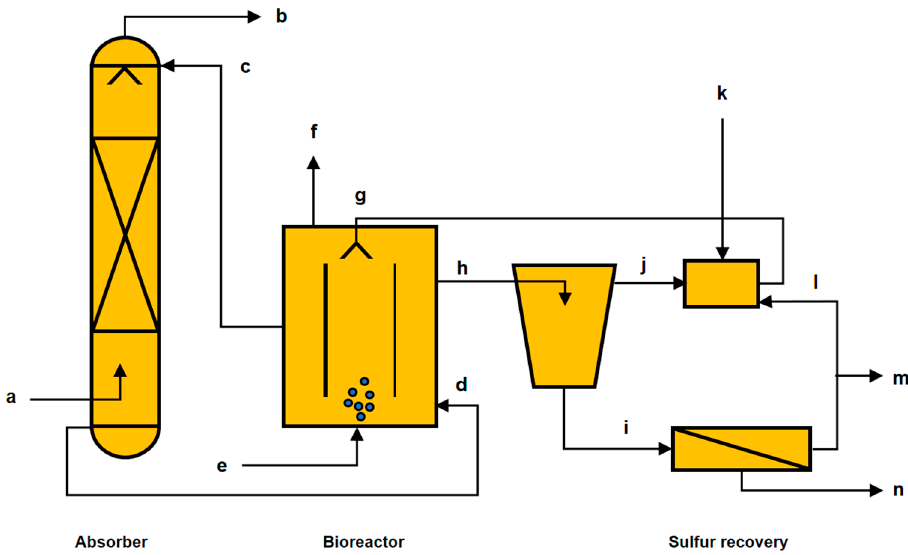
Figure 1. Flow scheme of the biotechnological process for gas desulfurization (adapted from [16]). ( a ) H 2 S-rich gas; ( b ) H 2 S-free gas; ( c ) H 2 S-free solution; ( d ) H 2 S-rich solution; ( e ) Air; ( f ) Air vent; ( g ) Make-up stream and recycled liquid fraction; ( h ) Sulfur rich solution; ( i ) Thickened sulfur stream from bottom of the settler; ( j ) Liquid fraction from top of the settler; ( k ) Make-up stream: nutrients, water and NaOH; ( l ) Residual liquid stream from sulfur separation; ( m ) Effluent stream; ( n ) Recovered sulfur.